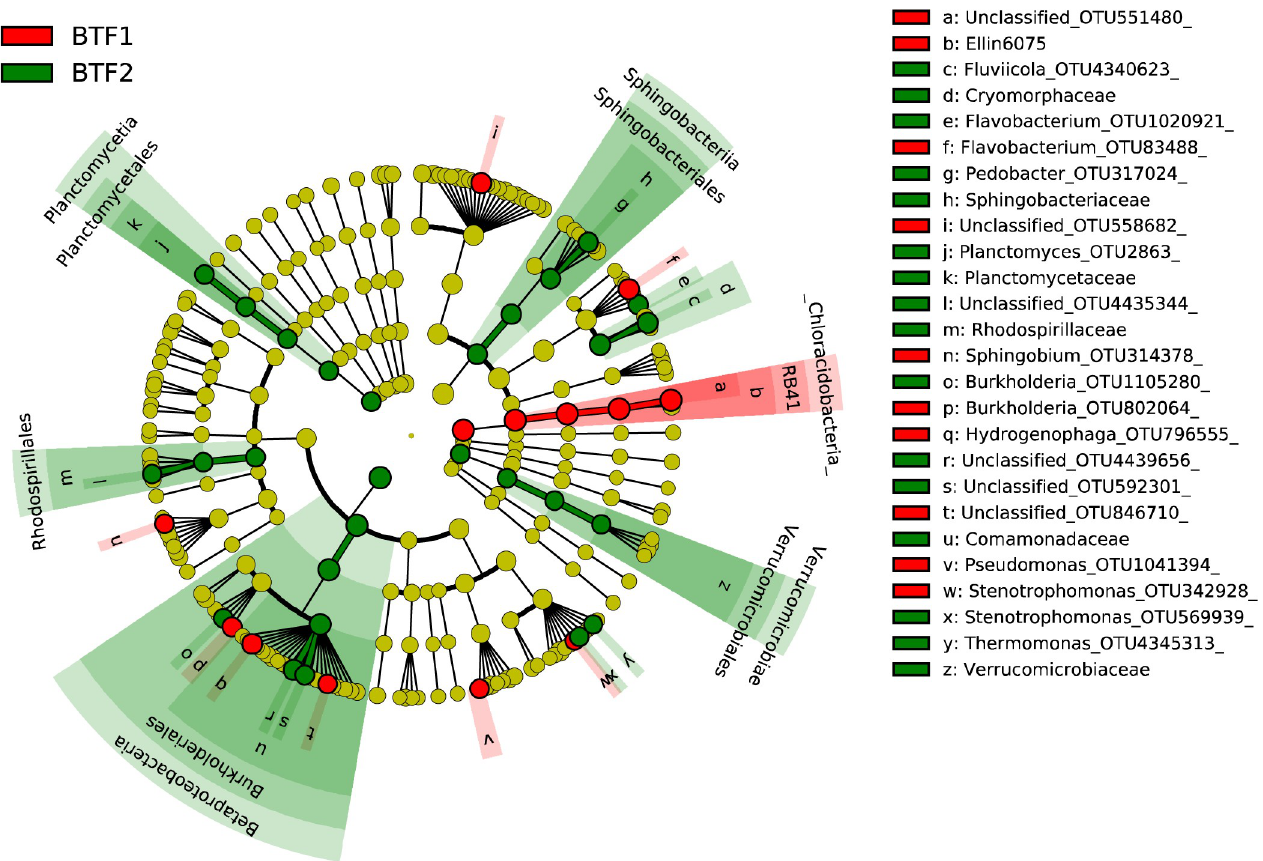
Fig 3. Linear discriminant analysis (LDA) effect size taxonomic cladogram highlighting the microbial biomarkers that statistically and biologically differentiate between the two BTFs. Significant (red and green) and non-significant (yellow) discriminant taxonomic nodes are colored. Circle diameter is proportional to the taxon’s